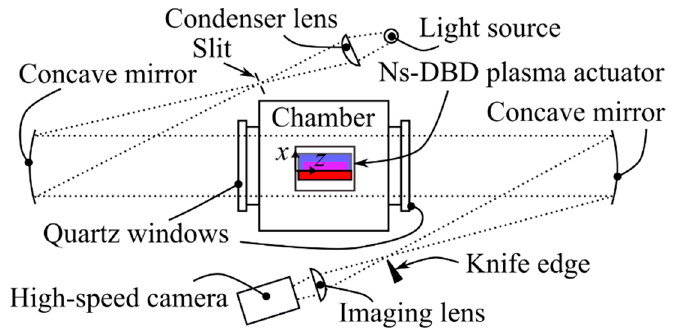
Figure 3. The Schlieren setup.